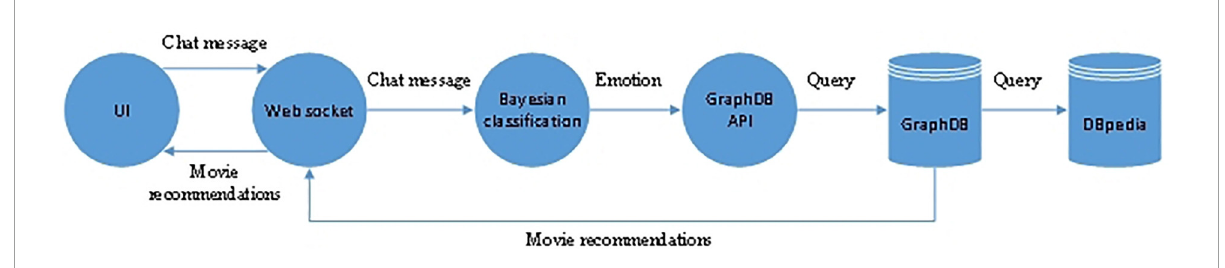
FIGURE4 The recommendation process based on KG (Breitfuss et al.,